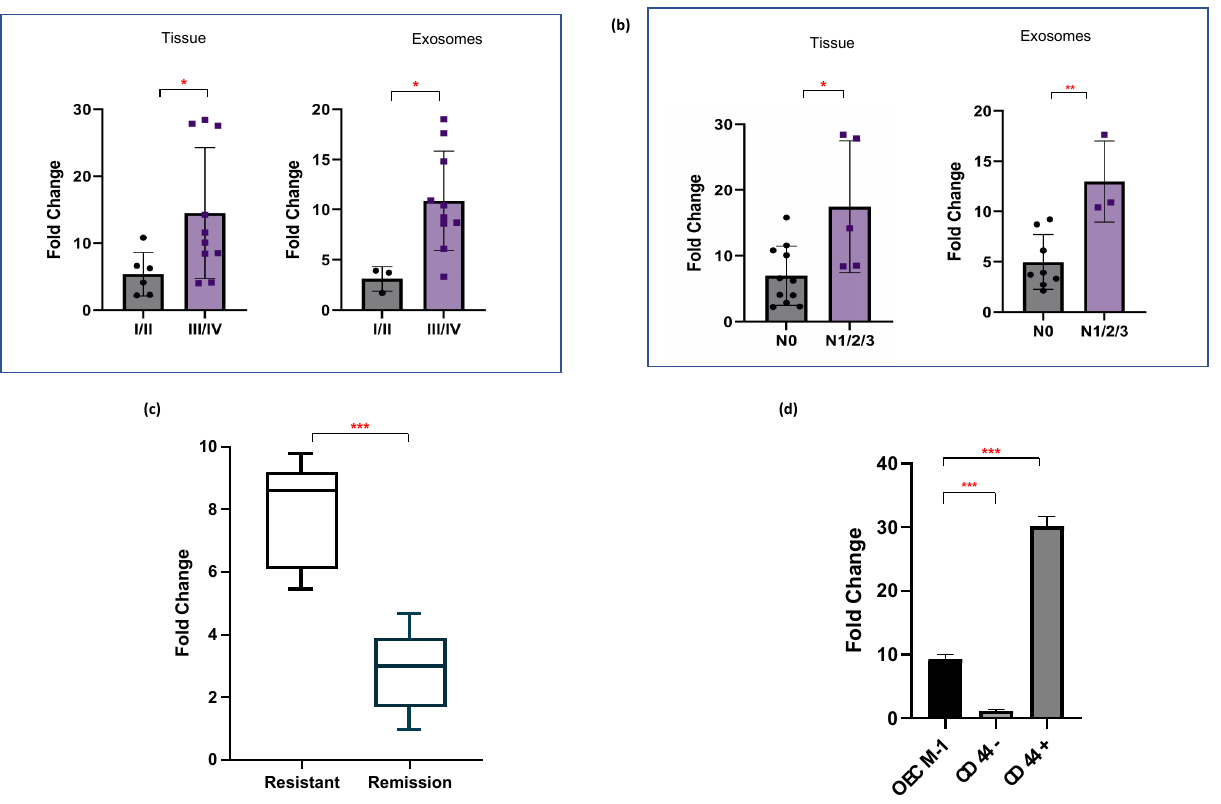
Figure 3. miR-1307-5p is overexpressed in late-stage tumours and refractory, chemoresistant tu- mours. Representative box plots depict relative expression patterns of miR-1307-5p in ( a ) early stages (Stage I/II) vs. late stages (Stage III/IV) of OSCC patient-derived tissue samples ( n = 19) and salivary exosomal samples ( n = 12), ( b ) OSCC tissue ( n = 19) and salivary exosome ( n = 12) samples of patients with no nodal metastasis (N0) vs those with metastasis (N1/2/3), and ( c ) salivary exosomal samples of OSCC patients with recurrent tumours and those with complete remission ( n = 25). ( d ) Expression of miR-1307-5p in CD44+ and CD44 − cells determined by qRT-PCR. The data were normalised with U6 values, and the relative miRNA levels were analysed using the ddCt method. Buccal scrapings and saliva samples obtained from healthy controls were used to calculate the relative expression of miR-1307-5p in OSCC tissue and salivary exosomes respectively. Expression of miR-1307-5p in OECM-1, CD44 − , and CD44+ samples was compared to buccal scrapings obtained from healthy controls. Error bars represent mean ± SD of three independent experiments. An unpaired t-test was conducted to determine statistical significance (* p ≤ 0.05; ** p ≤ 0.01; *** p ≤ 0.001).